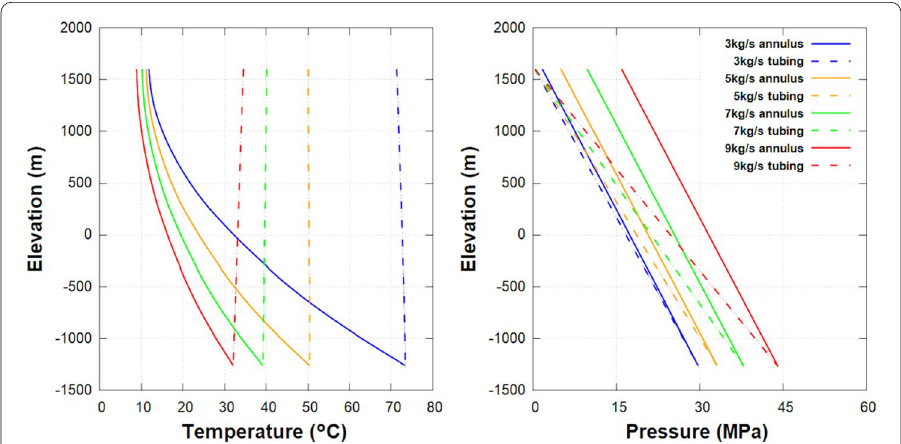
Fig. 5 Mass flow rate analysis over 30 years. Left—temperature vs. elevation for various ˙ m ( kg / s ) . Right— pressure vs. elevation for various ˙ m ( kg / s ) . Solid lines represent annulus and dashed lines tubing data, respectively. Legend applies to both graphs. All cases were compared with the base-case graph (in yellow)